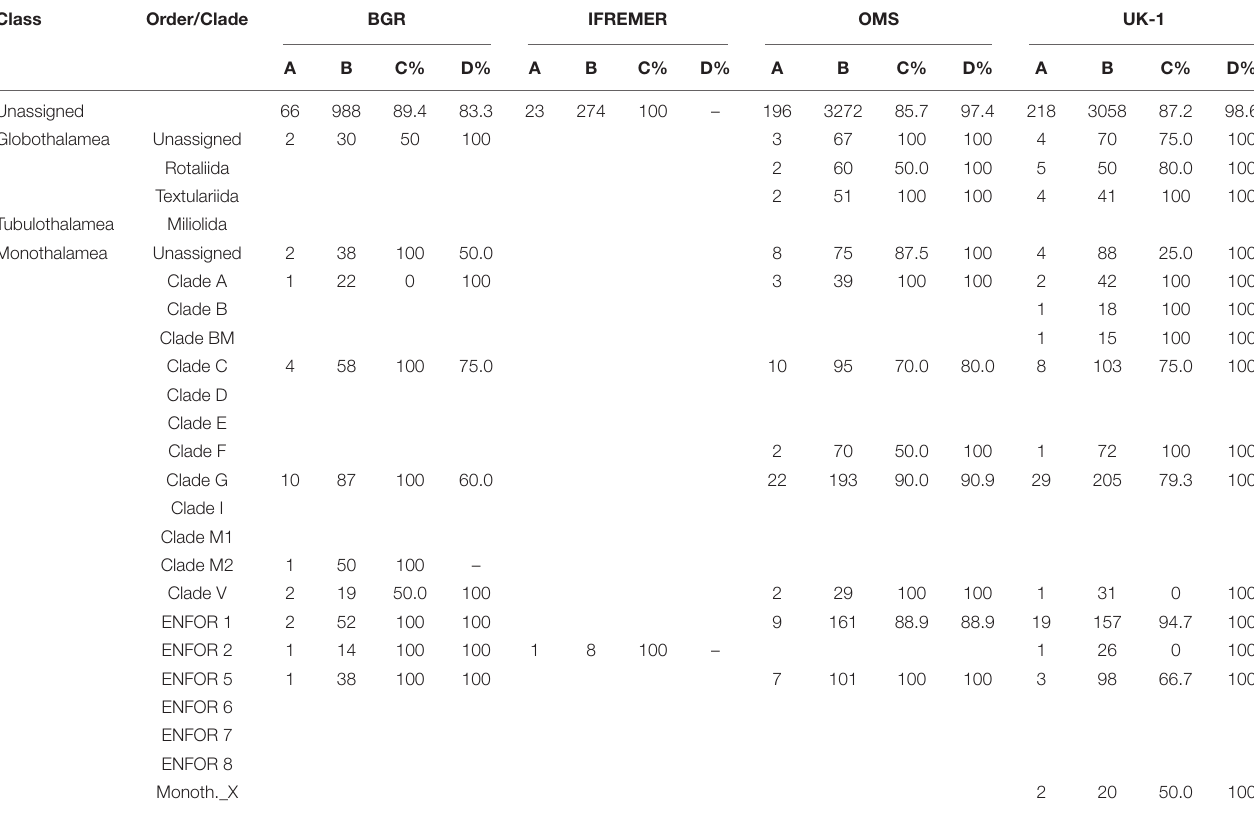
TABLE 5 | Number of OTUs that are confined to one CCZ area, station or single core. Data are arranged according to foraminiferal orders or clades and include only OTUs that are specific to CCZ areas and present in samples with > 1% of sequence reads. A = number of OTUs found only in this area. B = total number of OTUs in the full dataset. C = percent of ‘A’ found at only one station. D = percent of ‘A’ found in only one core from this station. Note that a dash in column D indicates that only one core was sampled for metabarcoding. Two cores per station were always sampled in the OMS and UK-1 areas, but only one core was sampled per station in the IFREMER area and at some of the BGR